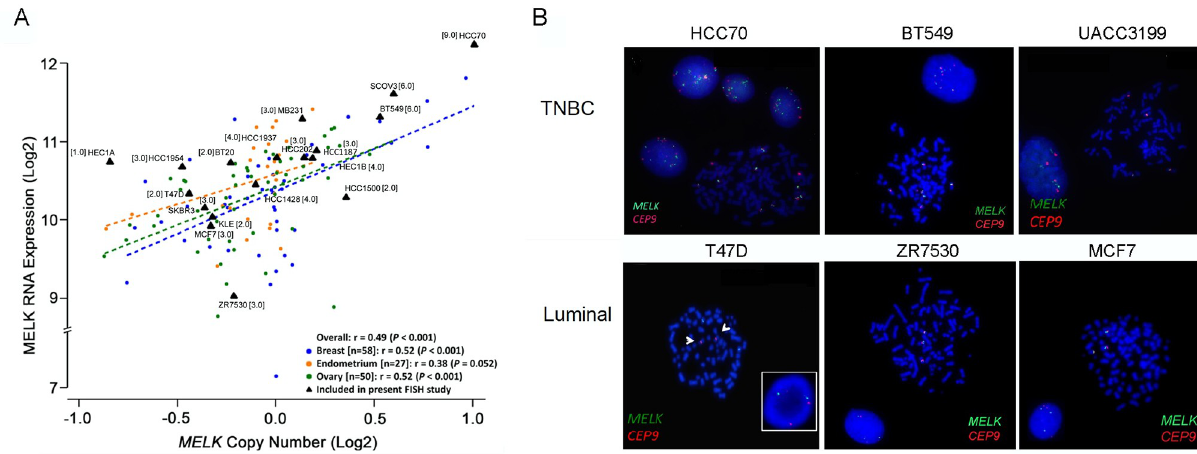
Fig 4. Correlation of MELK mRNA expression with copy numbers in breast cancer cell lines. (A) MELK RNA expression moderately correlates with MELK DNA CN in breast (r = 0.52, p < 0.001), endometrial (r = 0.38, p < 0.001), and ovarian cancer (r = 0.52, p < 0.001) cell lines from the CCLE cohort (n = 135). The X-axis represents CN and the Y-axis represents RNA transcripts. P -values were calculated using the Pearson correlation test. Labeled black triangles mark 18 cell lines analyzed by MELK / CEP9 FISH in present study. Brackets are the absolute mean MELK copies/cell. (B) FISH images of six representative cell lines (three TNBC and three luminal cell lines) with MELK gain and loss are given for comparison. MELK is localized by the green fluorescent signal and the CEP9 is localized by the red fluorescent signal. The cells were counterstained with DAPI (blue). The arrowhead indicates a structural alteration. Detailed FISH results are summarized in Table 1.